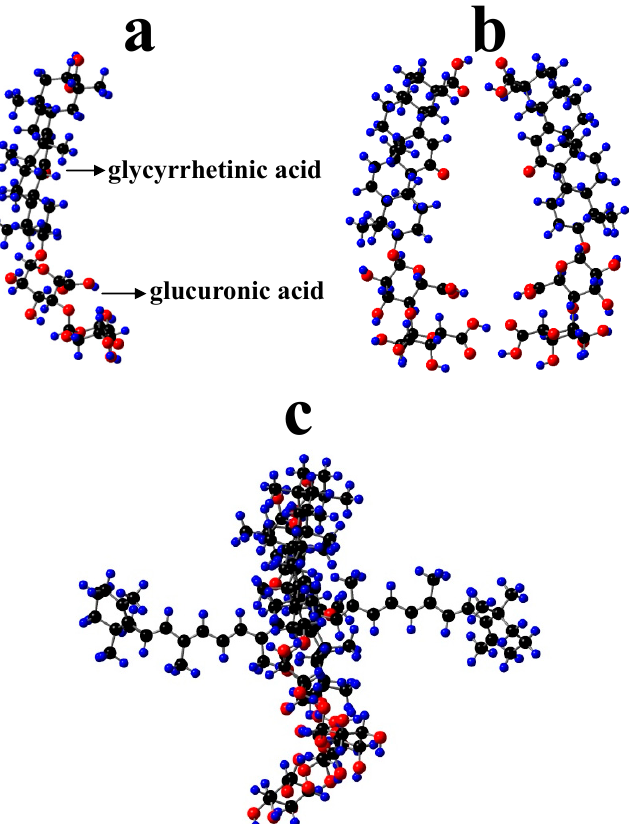
Figure 5. Optimized structures of ( a ) GA ( β -glycyrrhizic acid) showing glycyrrhetinic acid residue (nonpolar) and glucuronic acid residues (polar), ( b ) dimer of GA and ( c ) β -carotene-GA complex by AM1 semi-empirical method. H, blue; O, red; C,